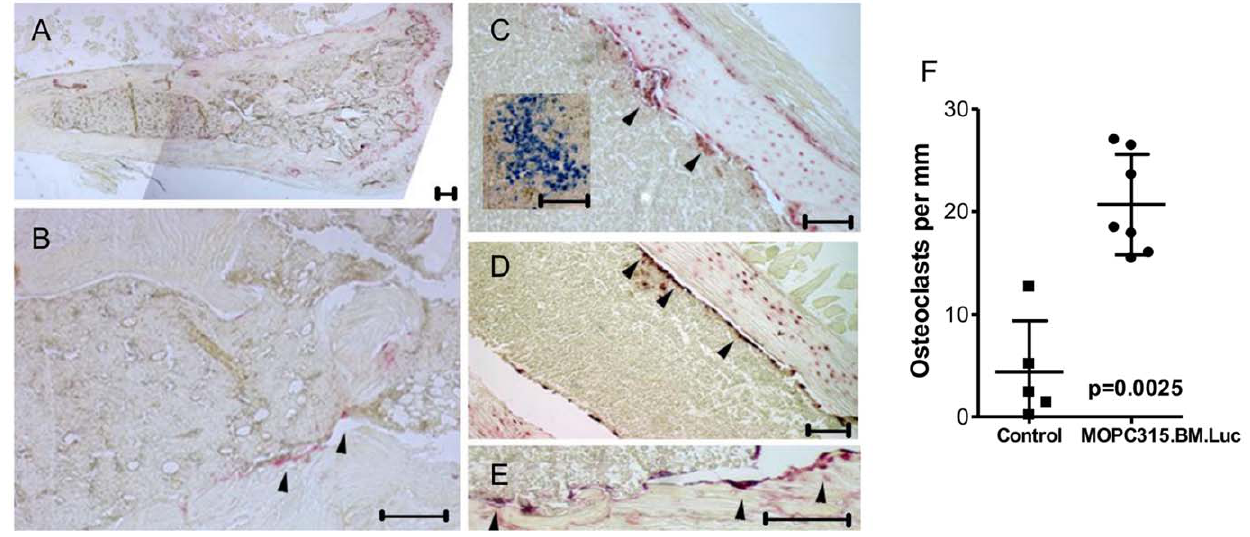
Figure 6. Osteoclasts in bone marrow of NSG mice infiltrated with MOPC315.BM.Luc. (A,B) Representative images of TRAP + staining from the bone marrow of an age-matched control NSG mouse injected with RPMI 1640. (C–E) Representative images of TRAP + staining from the bone marrow of an NSG animal injected with MOPC315.BM.Luc. Inset in (C) shows bone marrow localization of transplanted MOPC315.BM.Luc cells using staining for IgA. TRAP + osteoclasts are indicated by black arrow heads. In all cases scale bar is 200 m m. (F) Quantification of osteoclasts per mm bone surface. Controls are age-matched RPMI-injected NSG mice.